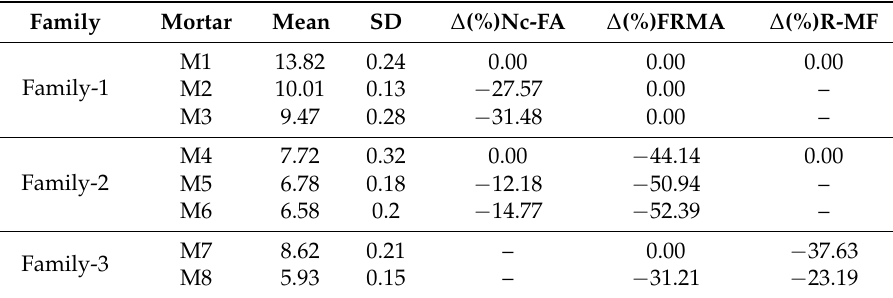
Table 12. Water vapor permeability of hardened